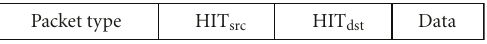
Figure 1: Structure of a HIP